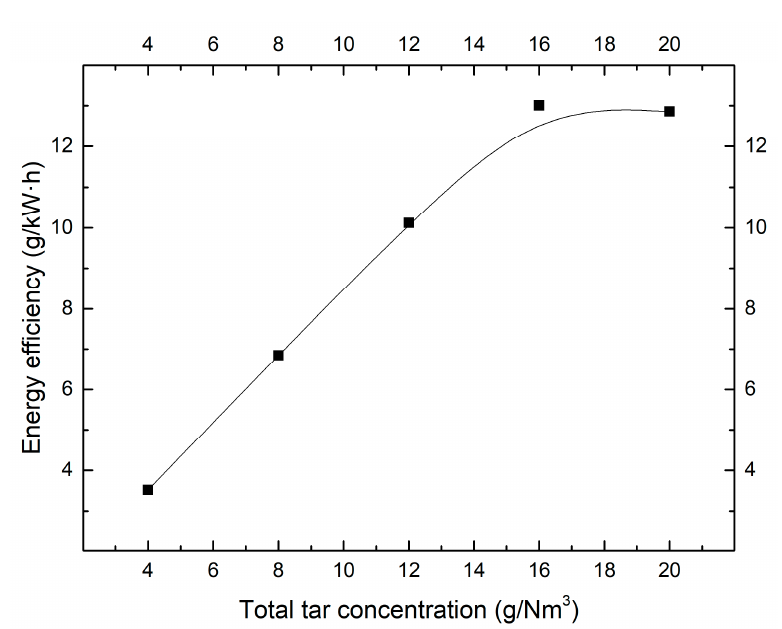
Figure 2. Effect of f tar concentration on the energy efficiency. Figure2. Effect of f tar concentration on the energy efficiency.